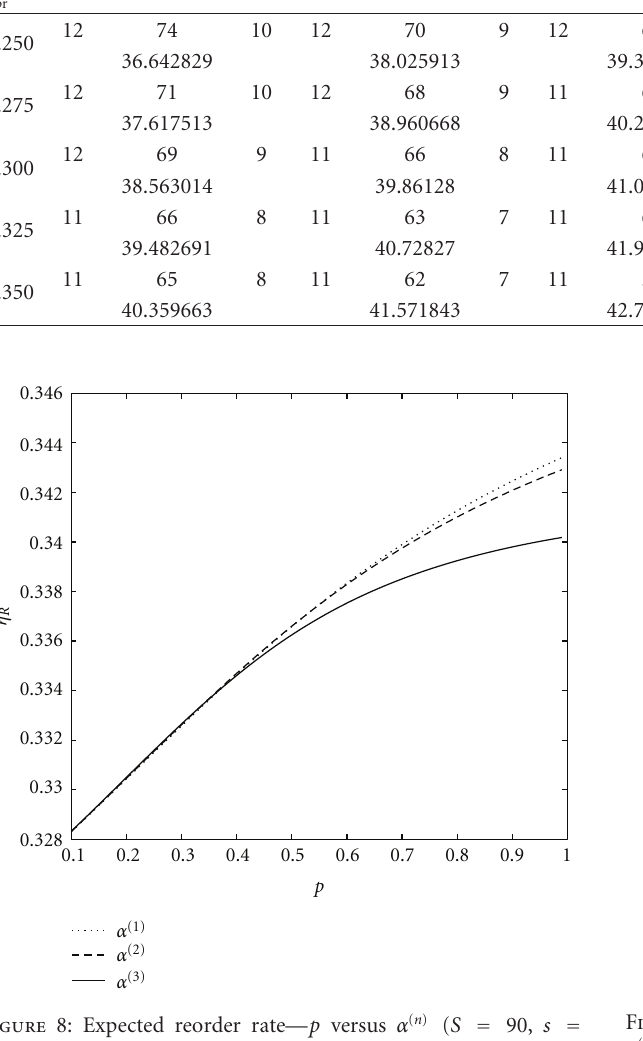
Figure 8: Expected reorder rate— p versus α ( n ) ( S = 90, s = 15, N = 25, λ = 8, β = 1 . 4, γ = 0 . 7, μ = 0 . 8.)